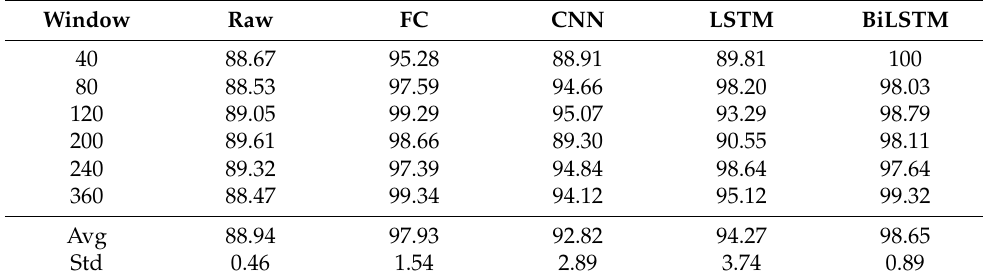
Table 11. Accuracy obtained by the unsupervised classifiers: Adjusted Rand.